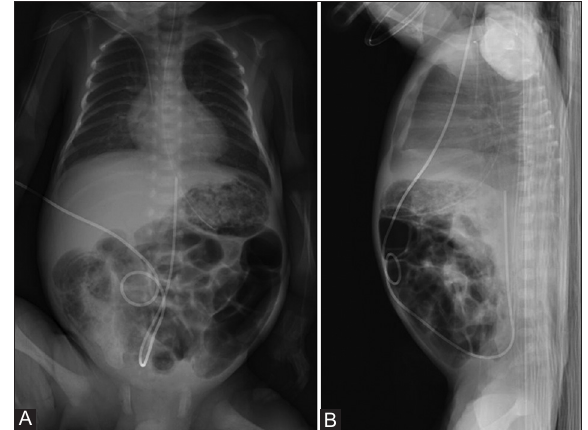
factant, and verification of the umbilical venous catheter in the liver. (B) Post-INSURE thoracoabdominal X-ray and verification of the peripherally inserted central catheter, for the removal of the umbilical venous